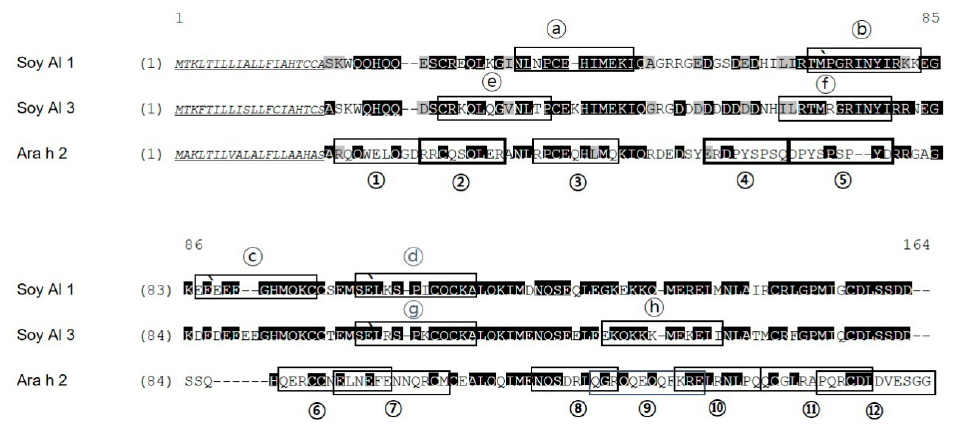
Figure 2. Alignment of Soy Al 1, Soy Al 3, and Ara h 2 amino acid sequences. Identical amino acids have a black background; similar amino acids have a gray background; signal peptides are underlined. The degree of similarity (identity) of Ara h 2 vs. Soy Al 1 and Ara h 2 vs. Soy Al 3 are 44.2% (35.6%) and 41.5% (34.8%), respectively. Epitopes identified are indicated with a black box. Immunodominant epitopes are indicated with a bold box.